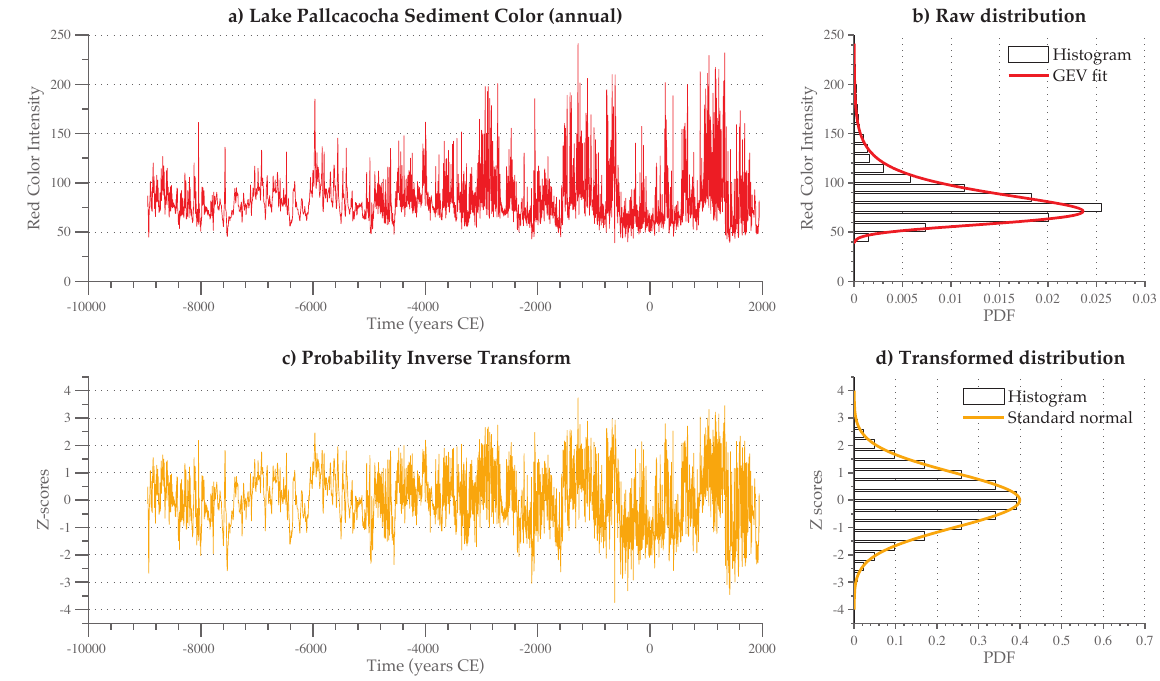
Figure 7. Raw and transformed time series of the Laguna Pallcacocha record (Moy et al., 2002). (a) Raw time series, interpolated at 2-year intervals; (b) empirical histogram (bars) and parametric fit to a GEV distribution with parameters ( k P ,σ P ,µ P ) = (0 . 07 , 15 . 59 , 72 . 13) (red line); (c) transformed time series with λ = 0 . 31; (d) empirical histogram of the transformed time series (bars) and parametric fit to a standard normal (red line).